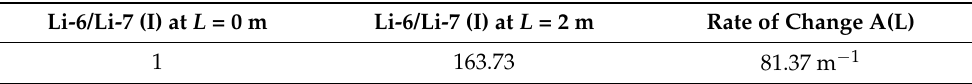
Table 36. The table shows the ratio Li-6/Li-7 (I ) that can take the range between the two values at L = 0 m and at L = 2 m and shows the rate of change in the ratio with respect to the length of gate L